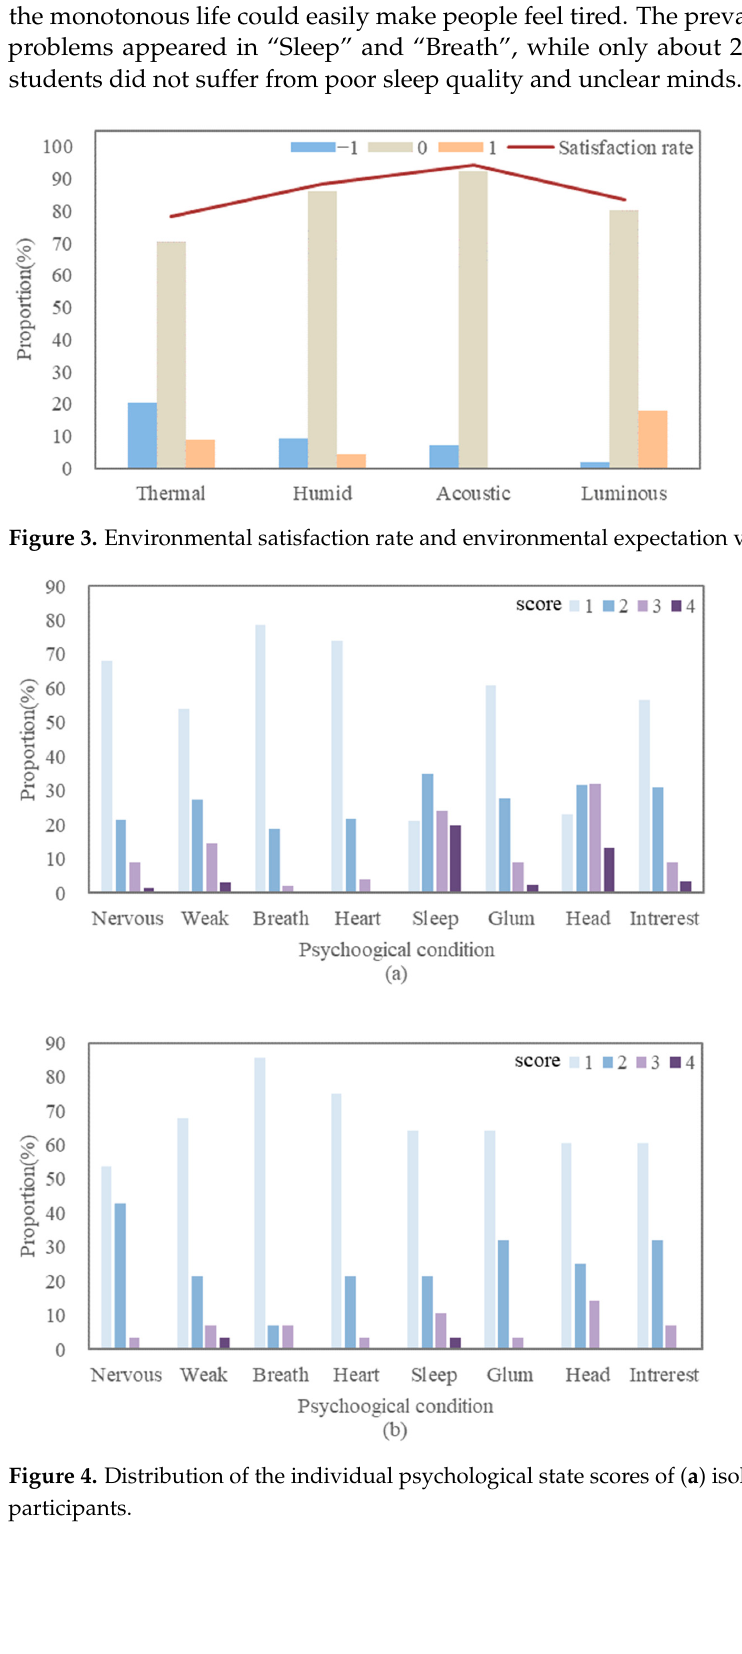
Figure 2. Environmental sensation vote.